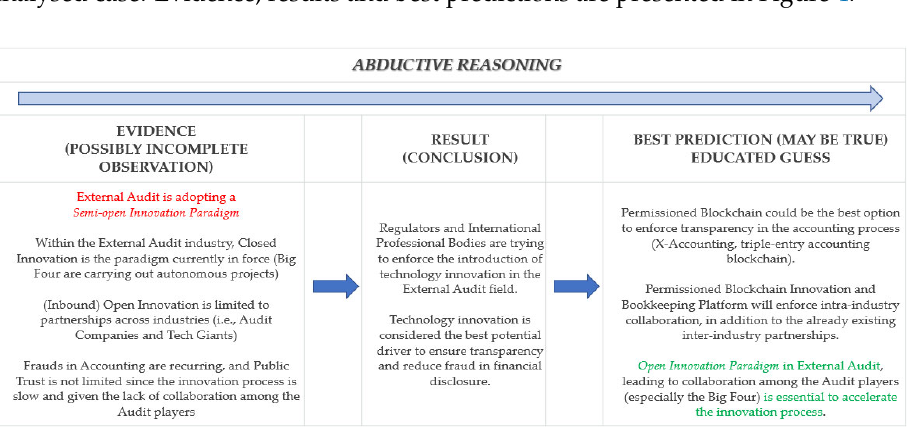
Figure 4. Abductive reasoning in external audit innovation paradigms analyses.